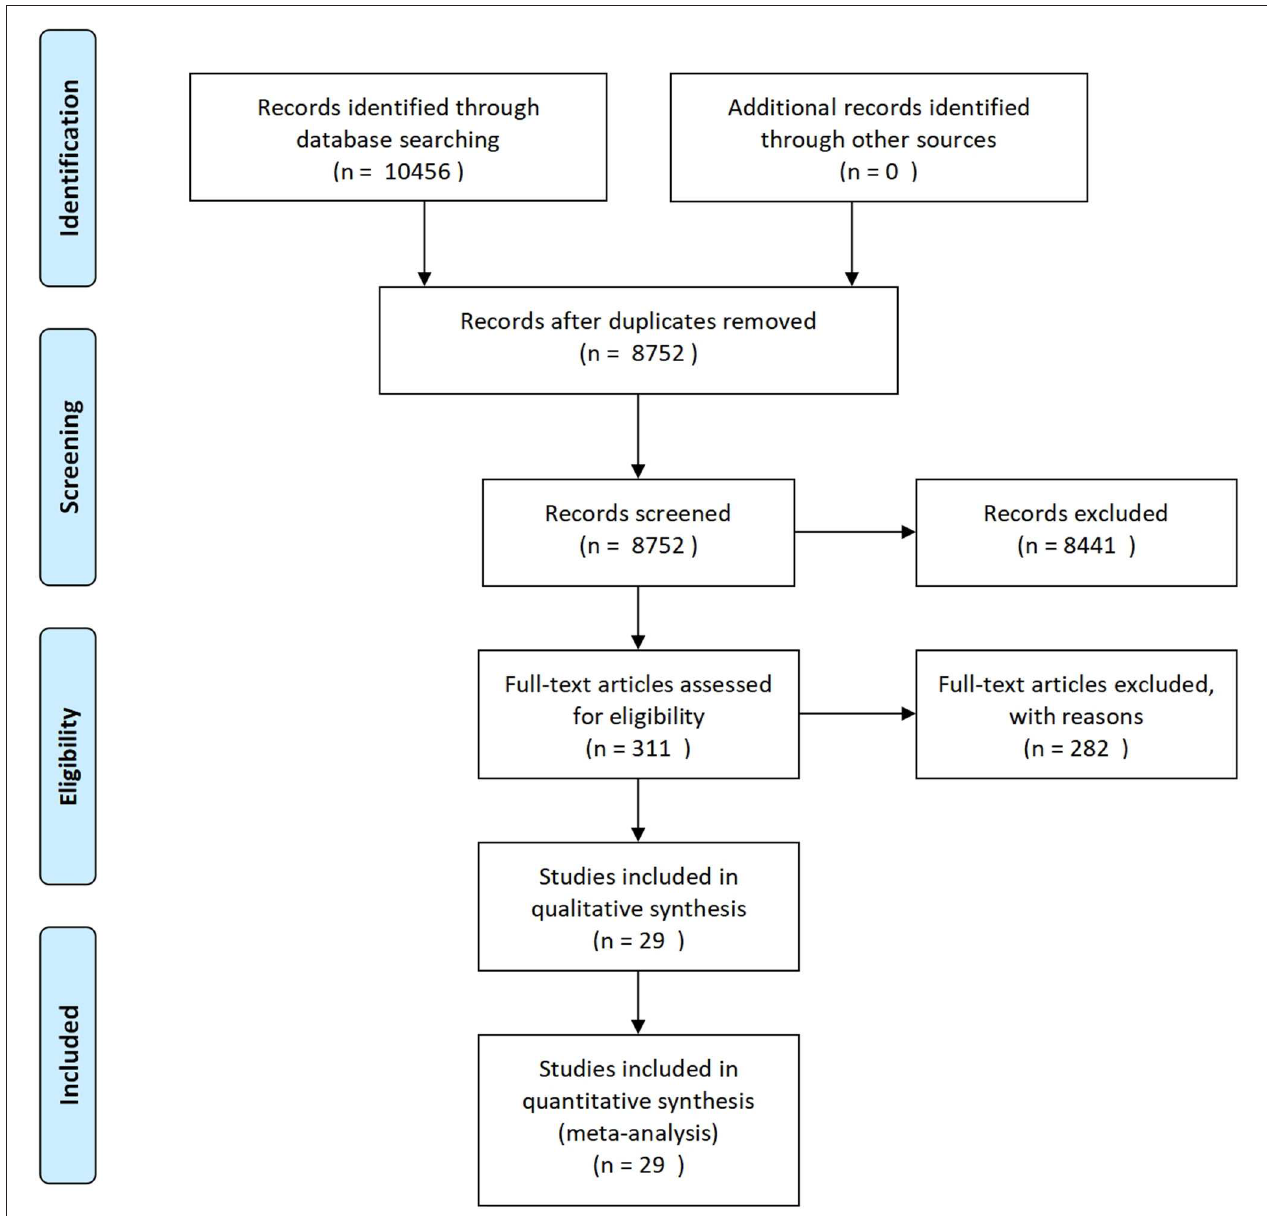
FIGURE 1 | PRISMA flow chart of the study selection